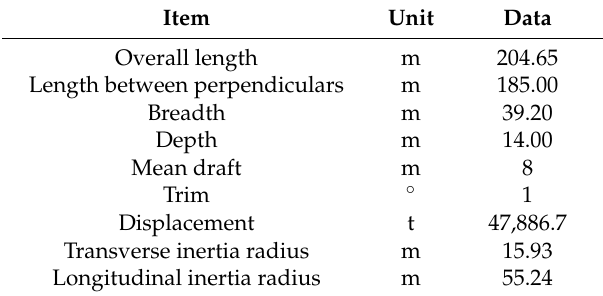
Table 1. HYSY201: pertinent